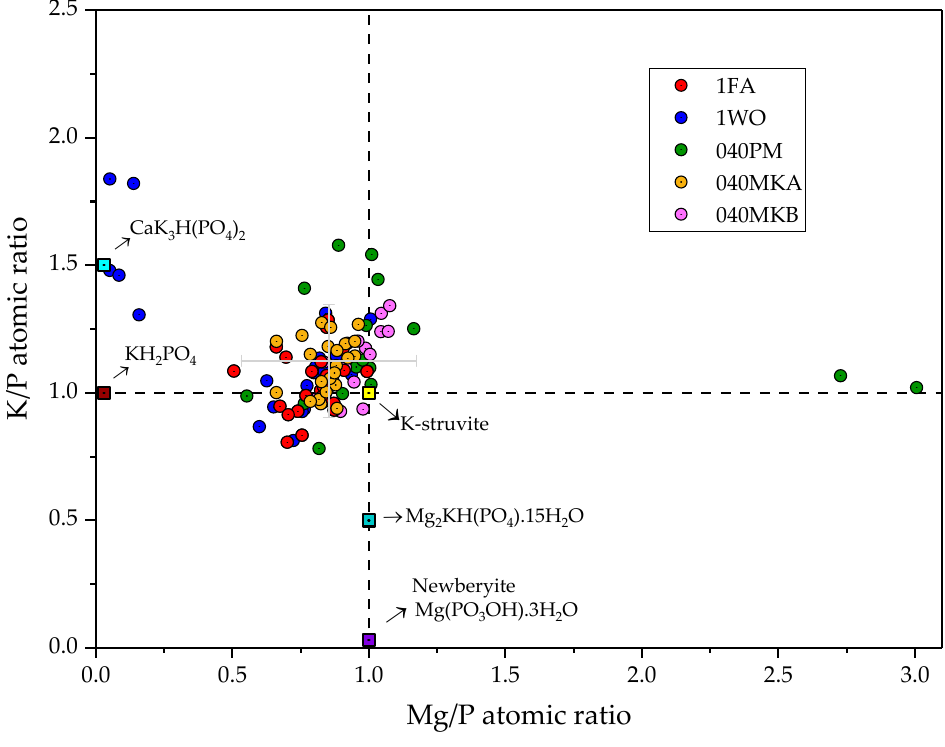
Figure 8. Atomic ratios of K/P and Mg/P in MKPC pastes after 28 days of curing measured by semiquantitative EDX analyses.